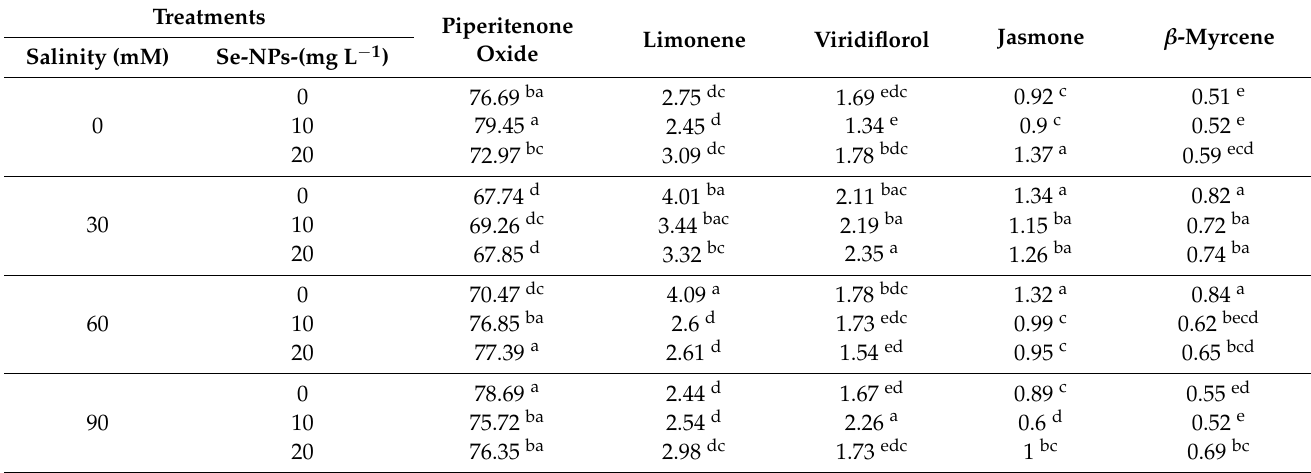
Table 4. Effects of foliar application of Se-NPs on the Essential oil components of pineapple mint plants under different salinity